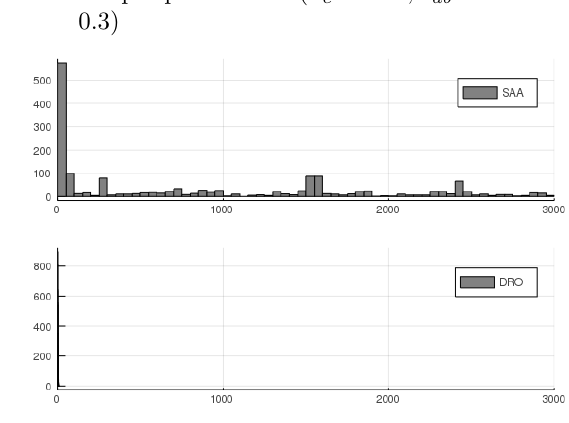
Figure 2. Histogram of out-of- sample performance( π c = 0 . 1 , π ab = 0 . 3)